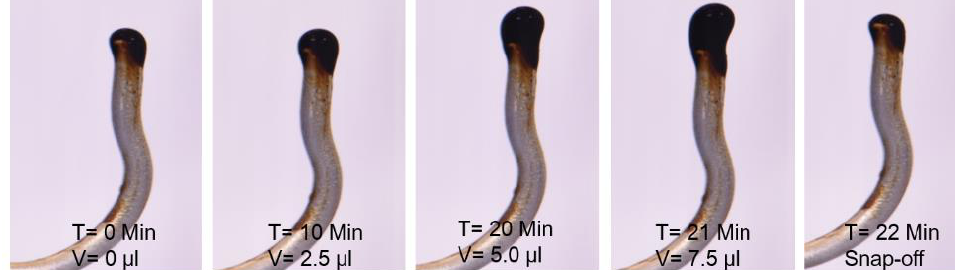
Figure 4. Static oil drop volume increase till snap-off point in SSW brine.